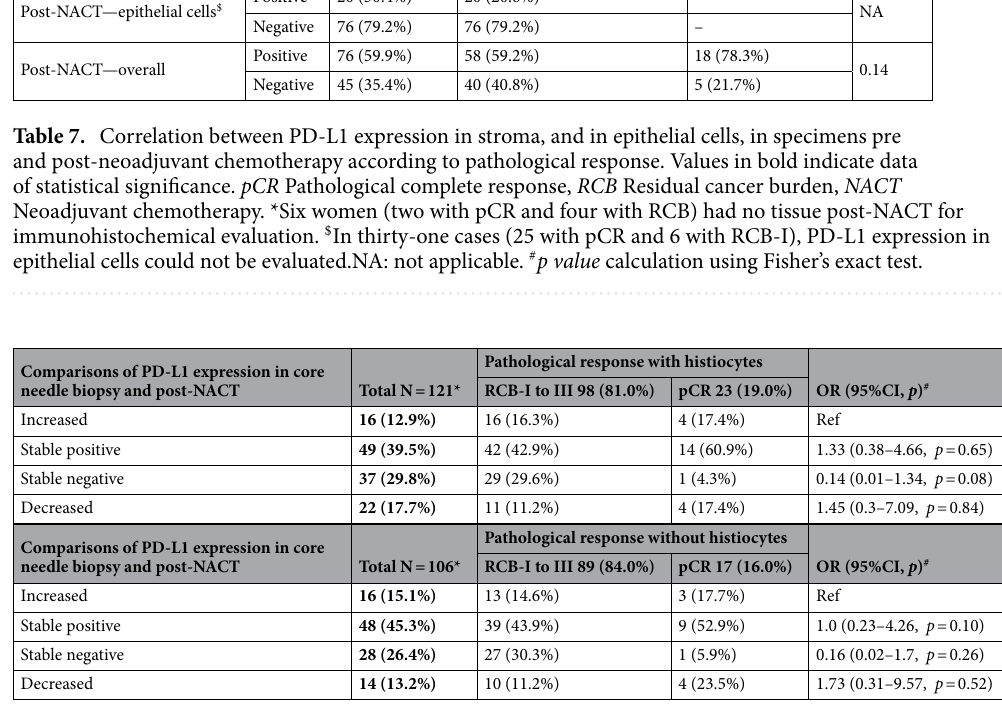
Table 8. Comparisons of PD-L1 expression in core needle biopsy and post-NACT surgical specimen according to residual cancer burden (RCB). *Six women (two with pCR and four with RCB) had no tissue post-NACT for immunohistochemical evaluation. Additional 15 cases were excluded because cellularity was constituted only by histiocytes. Ref: reference value; pCR: pathological complete response; RCB: residual cancer burden; sTILs: tumor infiltrating lymphocytes; NACT: neoadjuvant chemotherapy. # p value calculation using Pearson’s Chi-squared